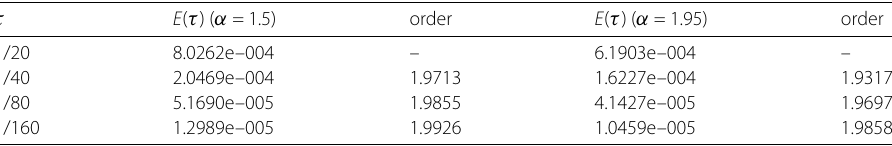
Table 6 ε n at t = t n for different values of α with h = 1